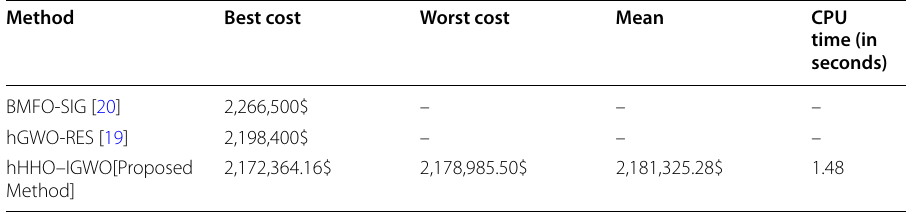
Table 10 Comparison of 40-unit wind–thermal system with other algorithms